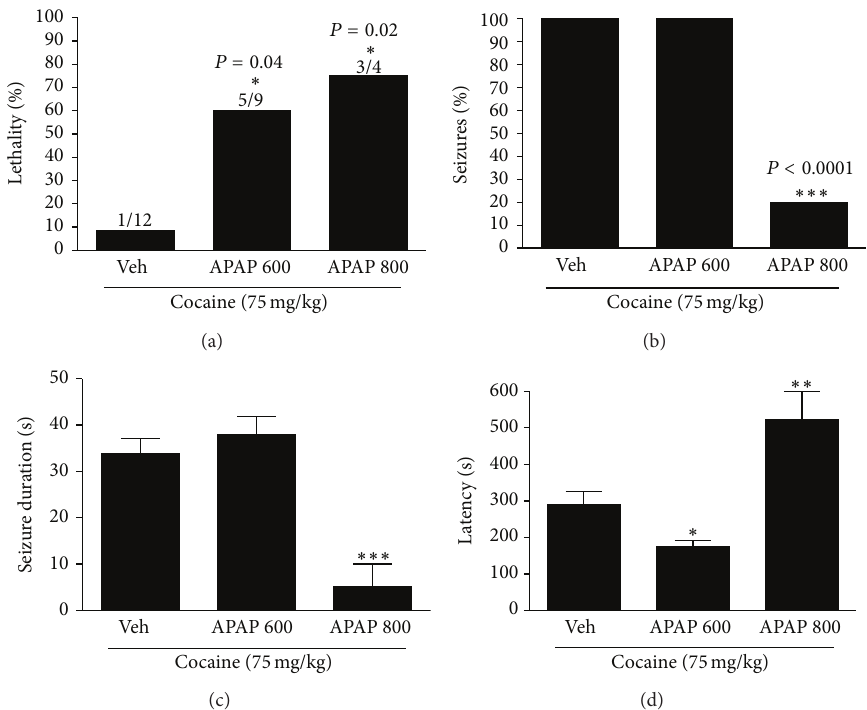
Figure 6: Previous hepatic injury (24 hours) with APAP interferes in seizure dynamics. (a) Administration of APAP at doses of 600 and 800 mg/kg 24 hours before cocaine administration increased lethality when compared to group vehicle/cocaine. (b) APAP at dose of 800 mg/kg reduced percentage of seizures and its duration (c). (d) Previous administration of APAP at dose of 600 mg/kg decreased seizure latency.APAPatdoseof800 mg/kgenhancedseizurelatency. ∗ Significantlydifferentfromvehiclegroup( ∗ 𝑃 < 0.05 ). ∗∗ Significantlydifferent from vehicle group ( ∗∗ 𝑃 < 0.001 ). ∗∗∗ Significantly different from vehicle group ( ∗∗∗ 𝑃 < 0.0001 ). One-way ANOVA with Tukey’s post hoc test. Data are expressed as mean ± S . E . M ( 𝑛 = 6